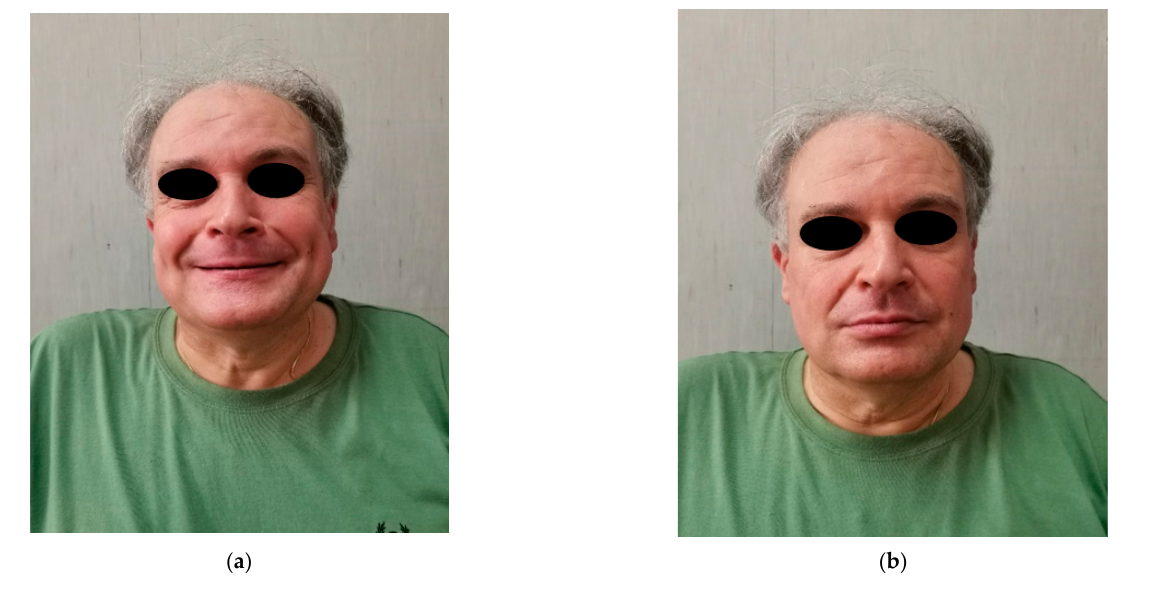
Figure 4. ( a , b ) Postoperative photos of our patient at 6-month follow-up, after Kabat therapy, with recovery of the facial nerve deficit.